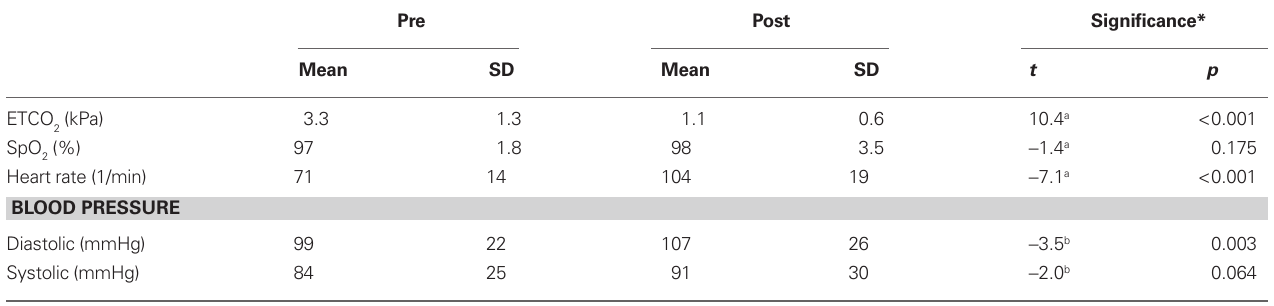
Table 1 | Group level mean values and standard deviations of physiological measurements in the state of normal ventilation ( Pre ), and the hyperventilation-modulated state ( Post ), and the statistical signifi cance of differences of group level changes between the states.